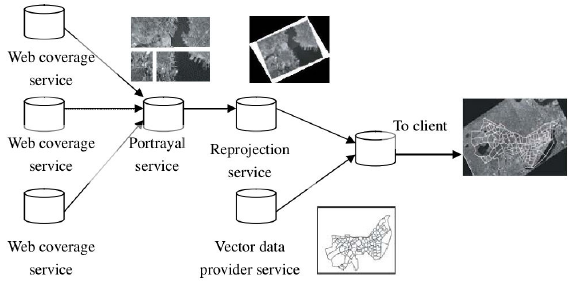
Figure 6. Data processing operation combination process.